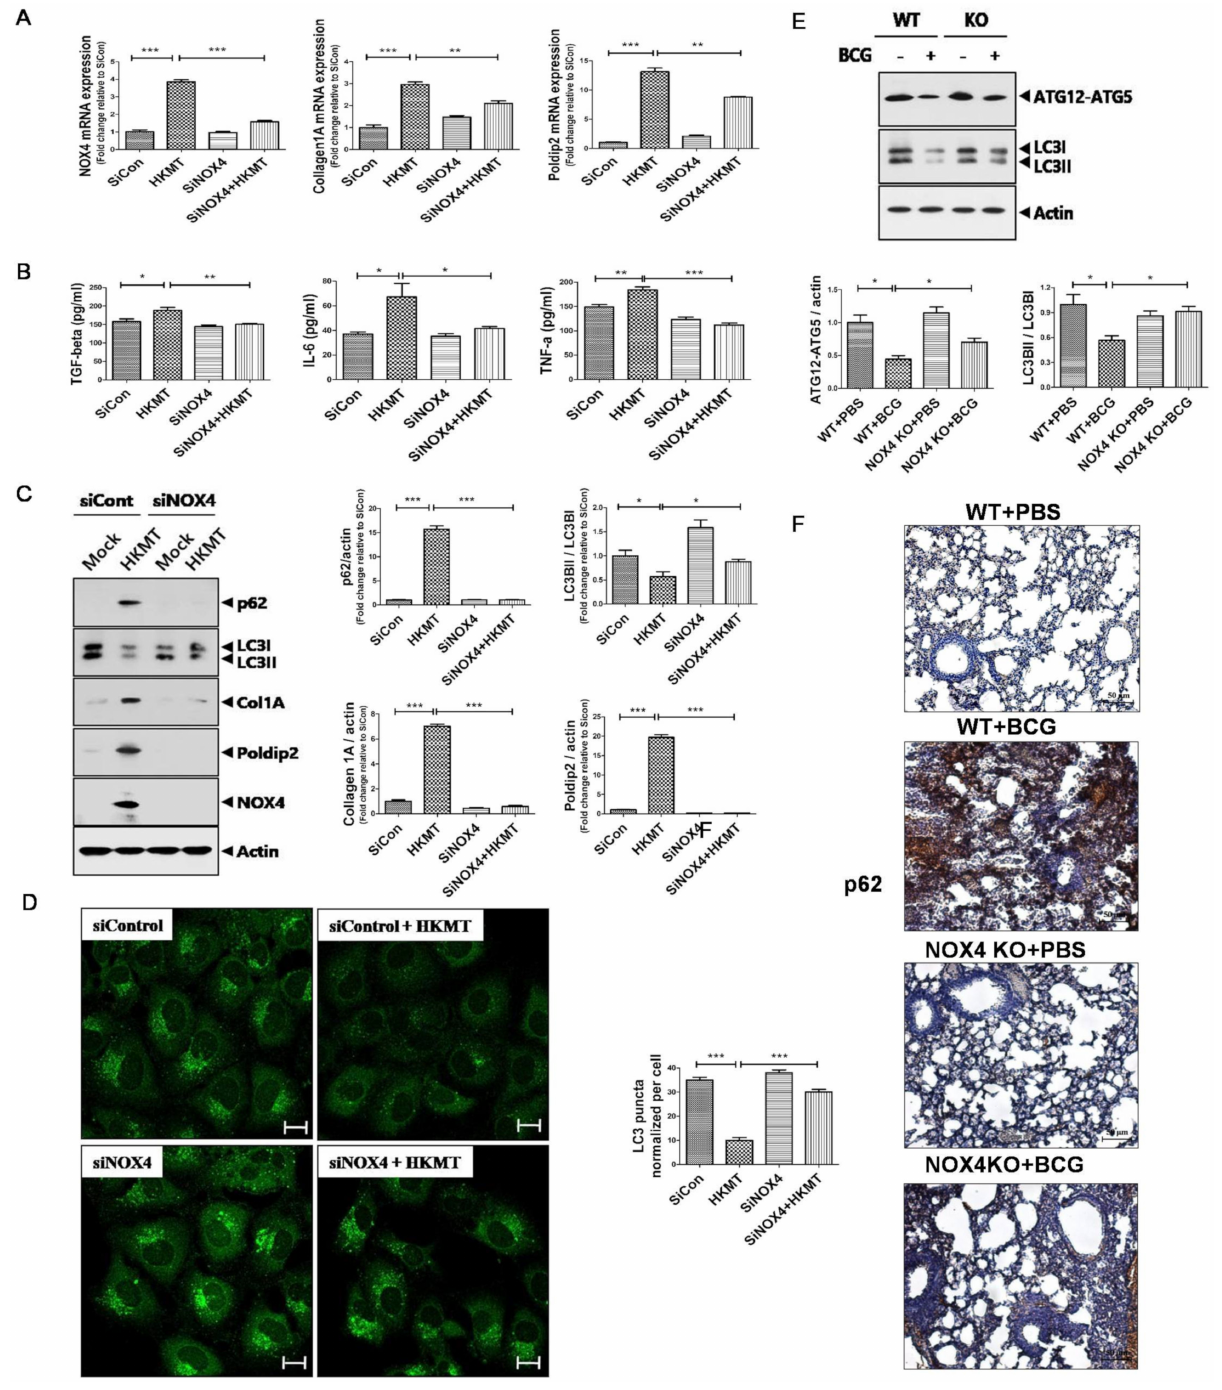
Figure 1. NOX4 mediates HKMT (heat-killed Mycobacterium tuberculosis ) -induced collagen synthesis via POLDIP2 and autophagy signaling: Human Met5A cells were transfected with siRNA targeting NOX4 (SiNOX4). After 1 day, Met5A cells were treated with HKMT (10 ng/mL) for 1 h or untreated ( A – D ). NOX4 mediates autophagy signaling in BCG (bacillus Calmette-Gu é rin)-induced lung fibrosis ( E , F ). ( A ) RT-PCR analysis ofNOX4, POLDIP2, and COL1A mRNA levels. ( B ) Cytokine levels (TGF- β , IL-6, and TNF-a) were assessed by ELISA in conditioned media of Met5A cells following transfection with siCon or siRNA targeting NOX4 (SiNOX4). ( C ) Western blotting of p62, LC3II/LC3I, collagen, POLDIP2, and NOX4. ( D ) LC3-puncta formation with quantification in Met5A cells with different treatments. Images were obtained by confocal microscopy (80 × ). Scale bar: 50 µ m. ( E ) Western blotting of ATG12-ATG5 and LC3B. ( F ) Immunostaining of p62 in mouse lungs (200 × ). Scale bar: 50 µ m. Results are presented as the mean ± SEM of at least three independent experiments. *** p < 0.001, ** p < 0.01, * p <